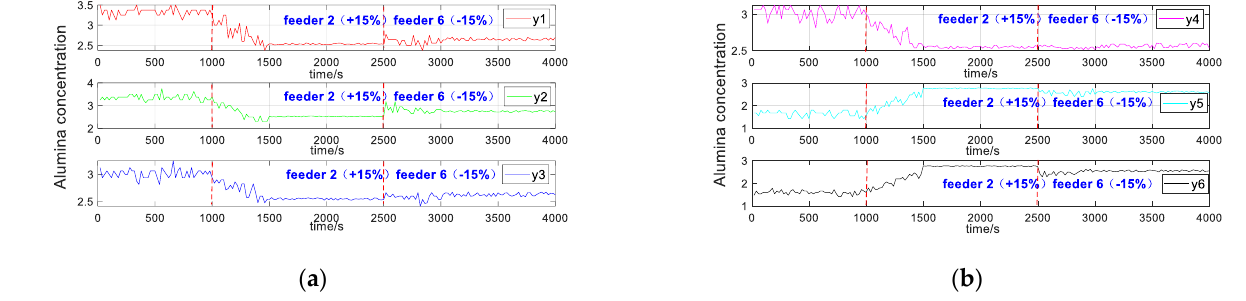
Figure 10. Variation of the alumina concentration: ( a ) subsystems 1 – 3; and ( b ) subsystems 4 – 6. As can be seen from Figure 10, after the simulation of a 15% increase and 15%